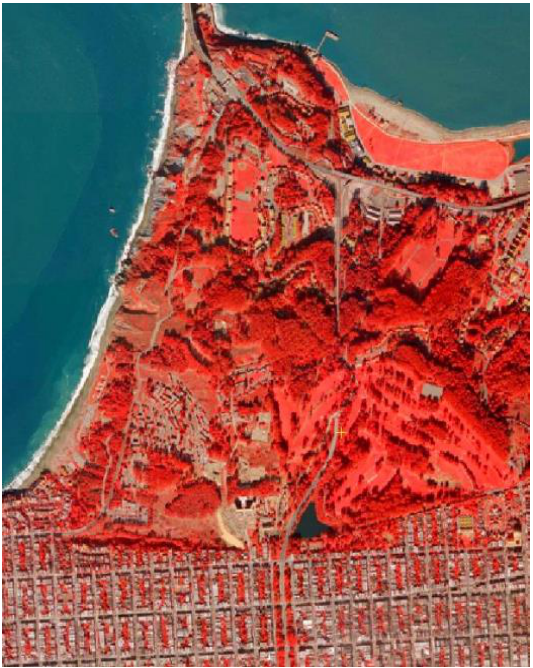
Figure 5: Color Infrared (CIR) ortho mosaic of area in